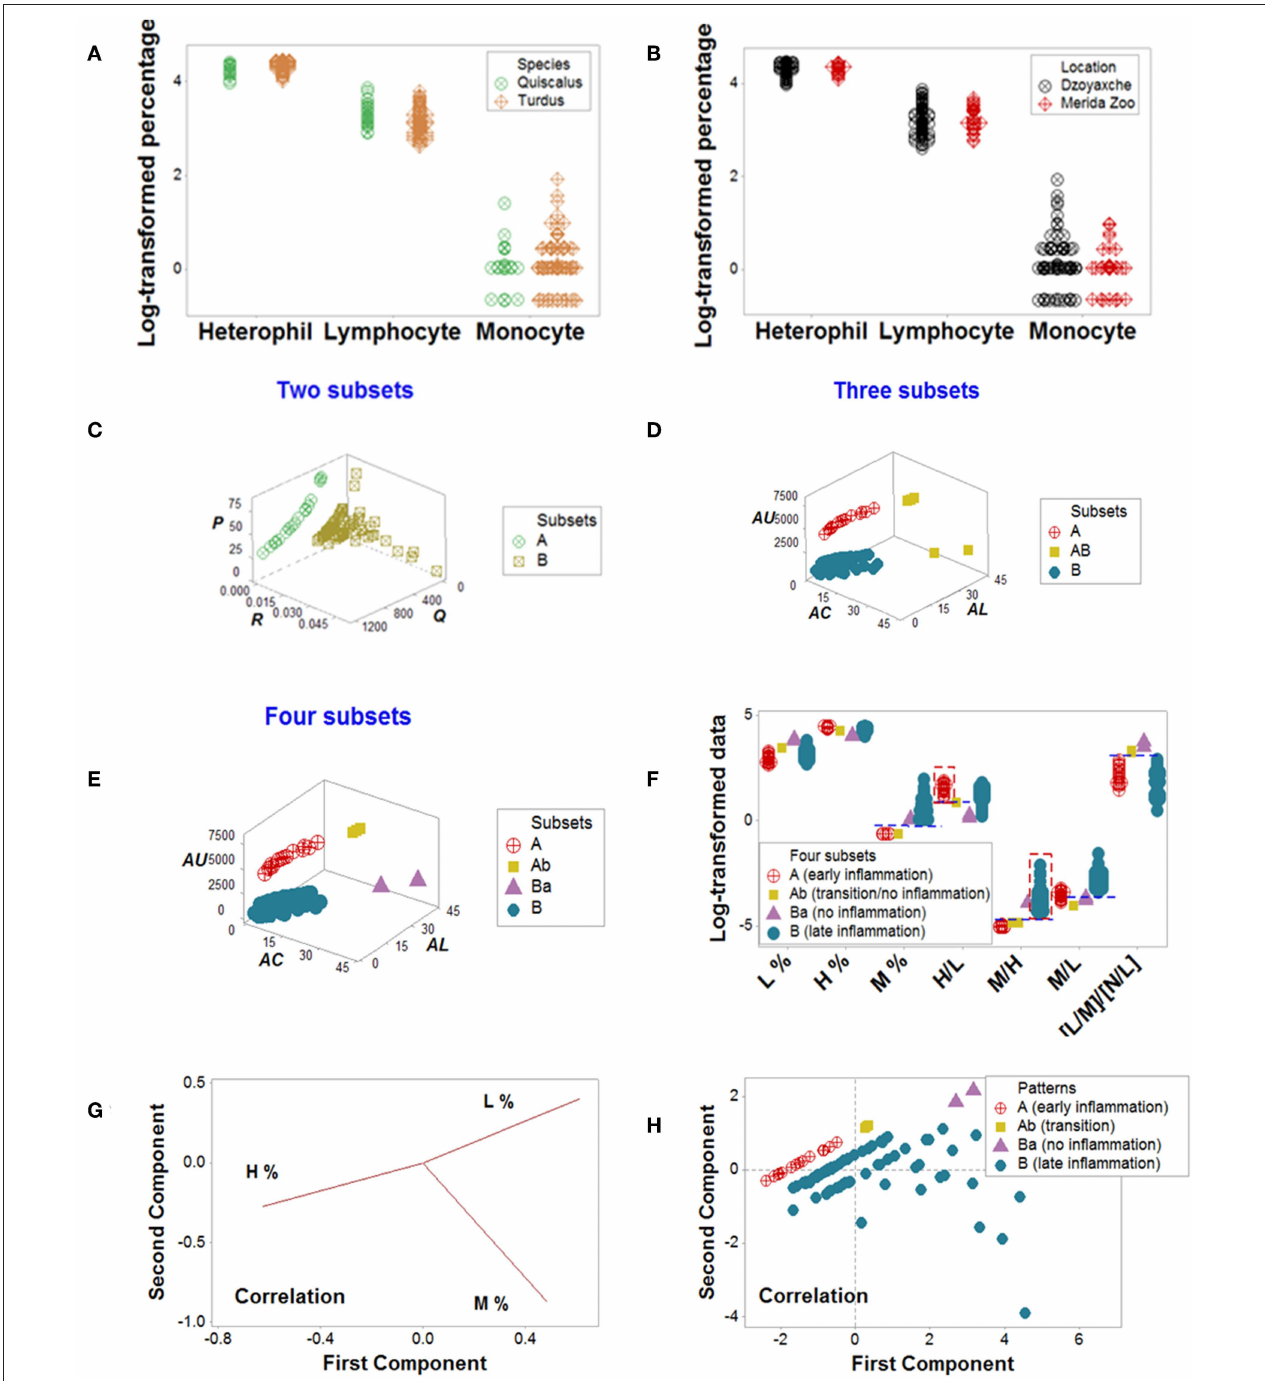
FIGURE 8 | Avian data—PRM and PCA assessments. Simple blood leukocyte indicators did not distinguish geographical sites or avian species (A,B) . Several complex data structures revealed the presence of up to four subsets (C–E) . When analyzed with biologically interpretable indicators, the data subsets displayed patterns consistent with no, early, or late inflammation (F) . The late inflammation group (subset B ) showed a significantly higher median M% than the early inflammation group (subset A , P < 0.01). Subset B exhibited a significantly higher median M/H than subset A ( P < 0.01, F ). In contrast, PCA did not discriminate (G, H) . Initials: lymphocytes (L), monocytes (M), and heterophils (H, the avian counterpart of mammalian neutrophils).